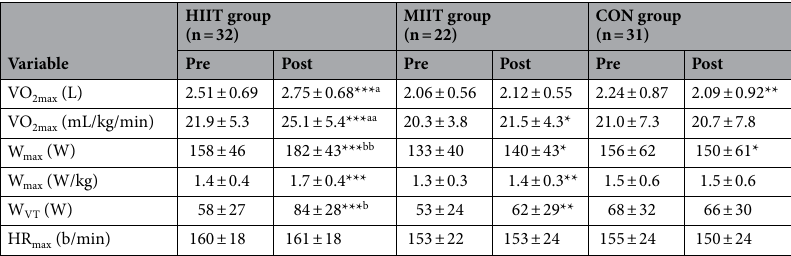
Table 4. Cardiorespiratory fitness and exercise performance variables pre- and post-intervention. Values are expressed as mean ± SD. HIIT high-intensity interval training group, MIIT moderate-intensity interval training group, CON control group, VO 2max maximal oxygen uptake, W max maximal power output, W VT power output at the ventilatory threshold, HR max maximal heart rate. *( p < 0.05), **( p < 0.01), ***( p < 0.001), significantly different from pre-intervention. a ( p < 0.05), aa ( p < 0.01), significant difference HIIT vs. CON; b ( p < 0.05), bb ( p < 0.01), significant difference HIIT vs. MIIT and